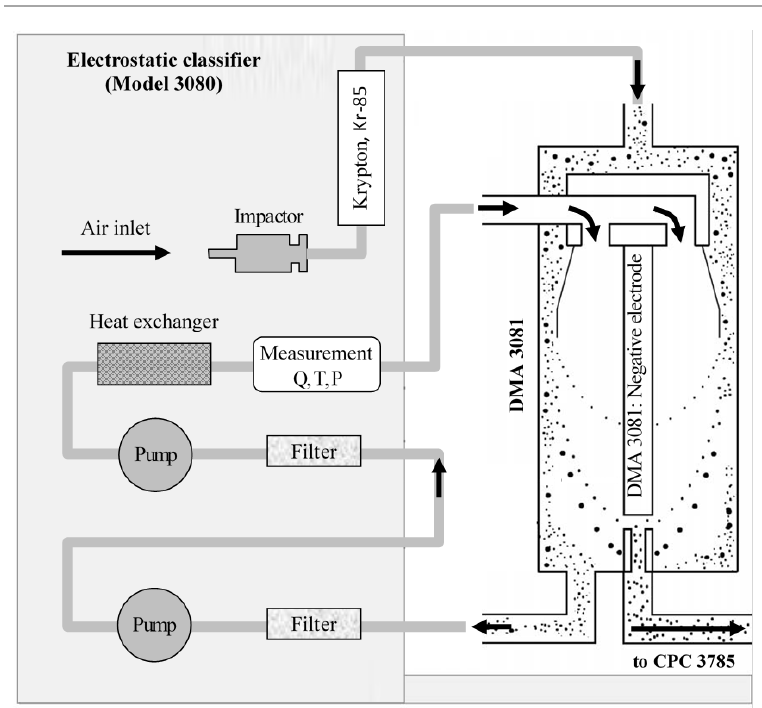
Figure 5. Classification of particles. The Model 3080 Electrostatic classifier (EC) scheme. (Q—flow rate, T—temperature, P—pressure).